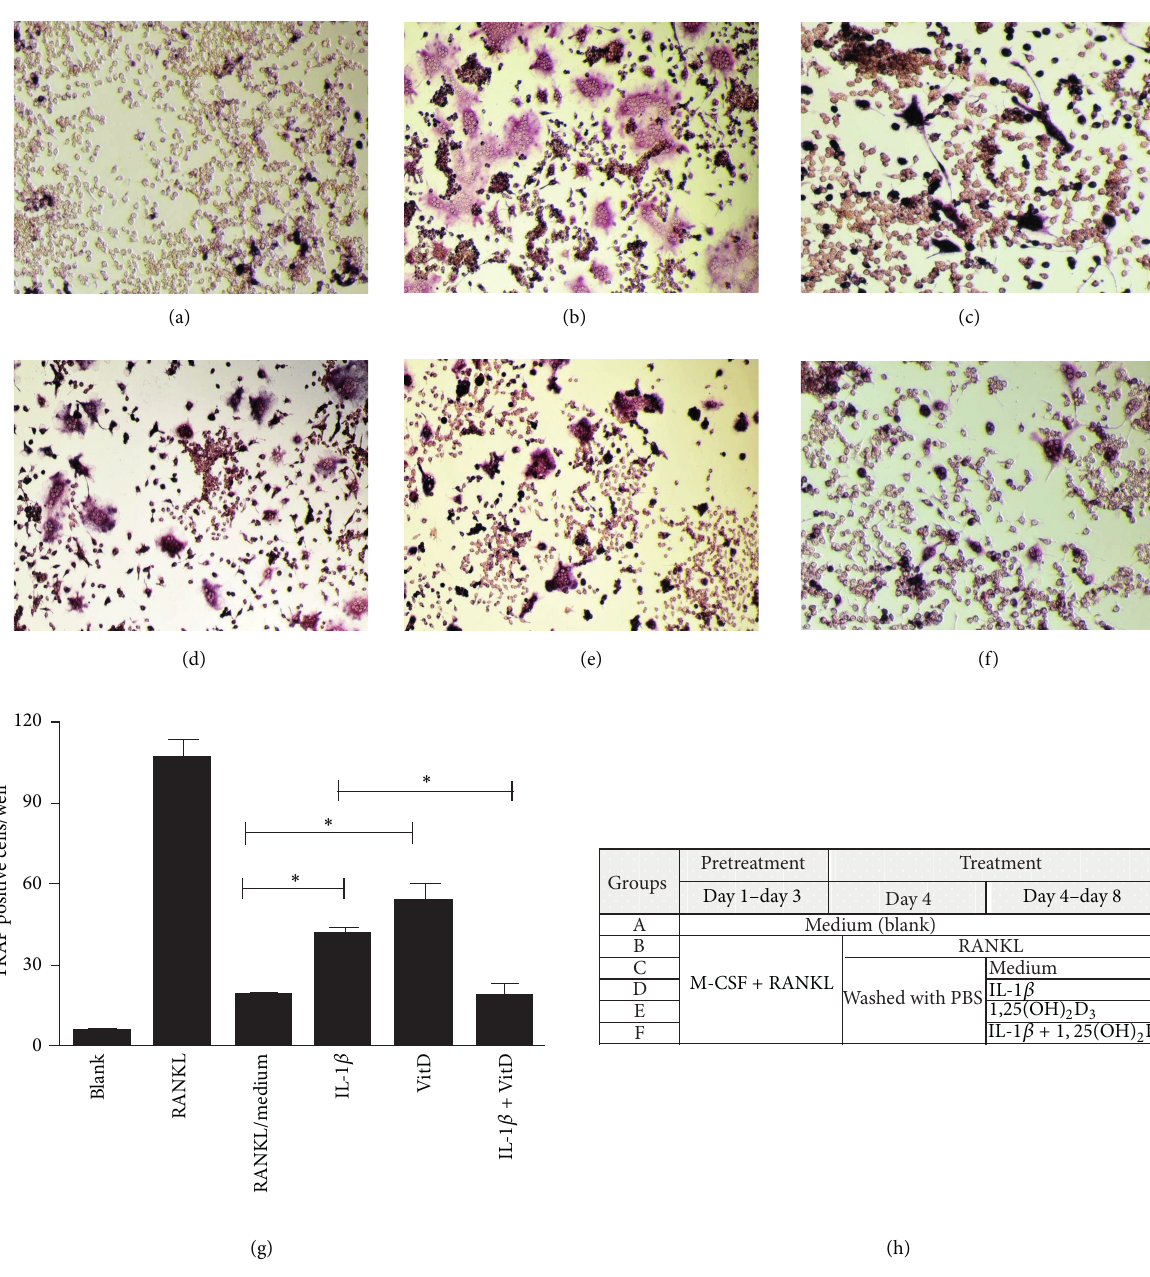
Figure 3: Effect of 1,25(OH) 2 D 3 on osteoclastogenesis in the presence of IL1 𝛽 in osteoclast precursors RAW264.7 cell line. RAW264.7 were treated with M-CSF (20ng/mL) and RANKL (50ng/mL) for 3 days. At 3 days pretreatment, cells were washed three times with PBS and were then incubated with IL1 𝛽 (20ng/mL) in the presence or absence of 1,25(OH) 2 D 3 (10nM) or 1,25(OH) 2 D 3 alone for 5 days. TRAP positive cells with numerous ( > 3) unstained nuclei were considered as mature osteoclasts. RAW264.7 treated with medium as negative control was shown in (a). TRAP positive cells in unwashed RAW264.7 treated with RANKL continually were shown in (b) and in washed RAW264.7 cells treated with medium were shown in (c). After washing, TRAP positive cells in RAW264.7 incubated with IL1 𝛽 , 1,25(OH) 2 D 3 or IL1 𝛽 plus 1,25(OH) 2 D 3 were shown in ((d)–(f)). TRAP positive cells number in different groups were shown in (g) ( ∗ 𝑃 < 0.05 ). The diagram of treatment process in RAW264.7 was shown in